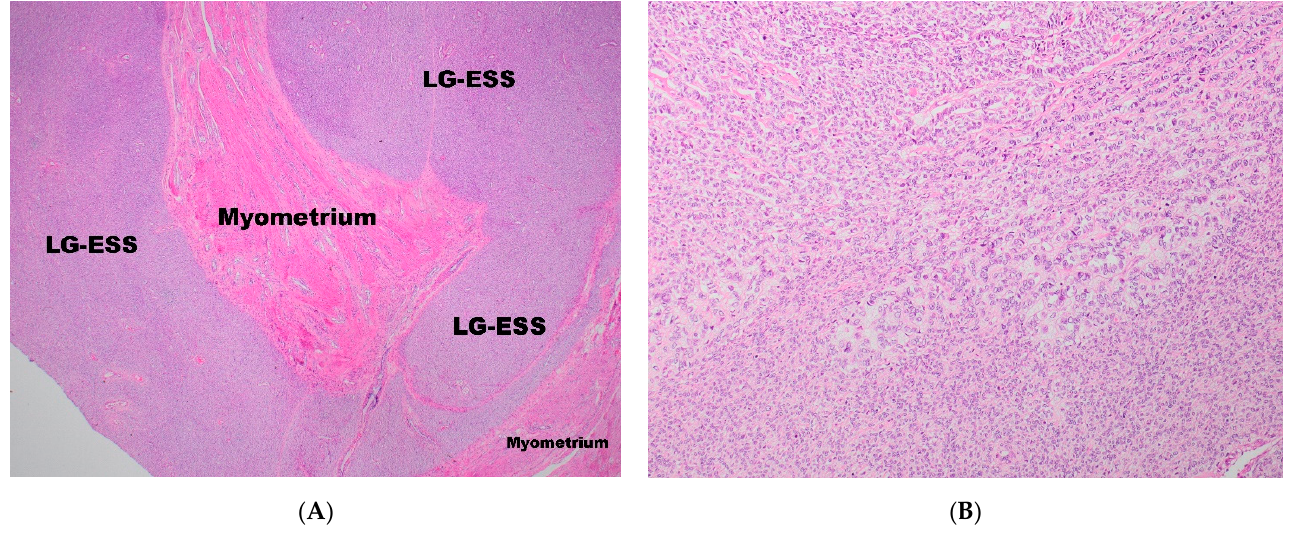
Figure 2. ( A ) The infiltrative, tongue-like margin in LG-ESS. ( B ) Sex-cord-like structures in